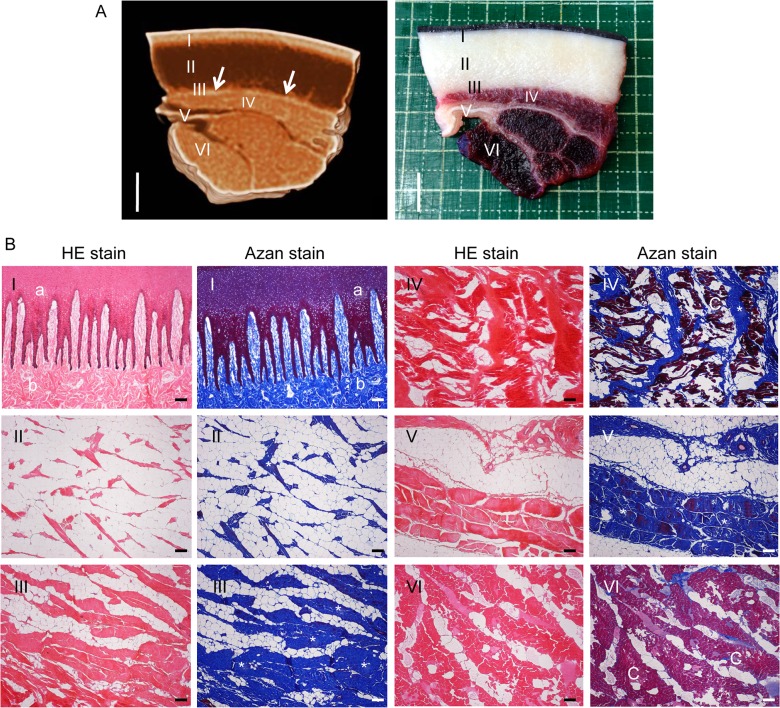
Detection of brown adipose tissue in dolphin blubber by CT scanning.(A) CT observation of bottlenose dolphin blubber block (EL-13175) with thin, highly dense layer indicated by arrows (left panel). Cross section of the block roughly corresponding to the CT image (right panel). Scale bar = 1 cm. (B) Sampling sites for histology labelled I–VI in A. Left panel, HE stain. Right panel, Azan stain. a, epidermis; b, dermis; c, skeletal muscle. Connective tissues indicated by asterisks.